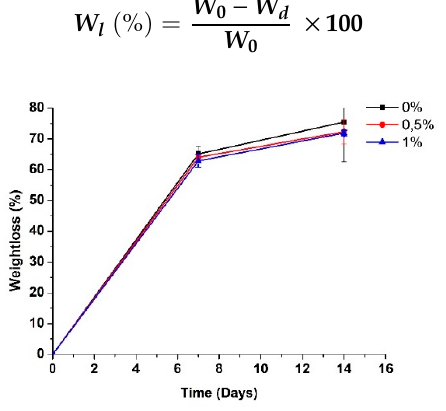
Figure 3. Weight loss of electrospun CS/PVA/GO composite nanofibrous membranes with different GO amounts (0%, 0.5%, and 1.0%), after several periods of immersion in a simulated biological fluid SBF.